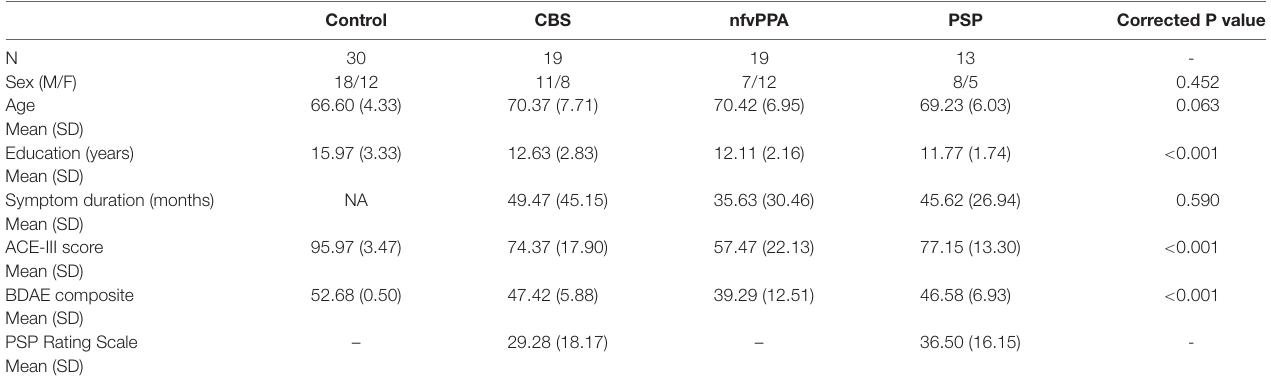
TABLE 1 | Demographic information for the study cohort.